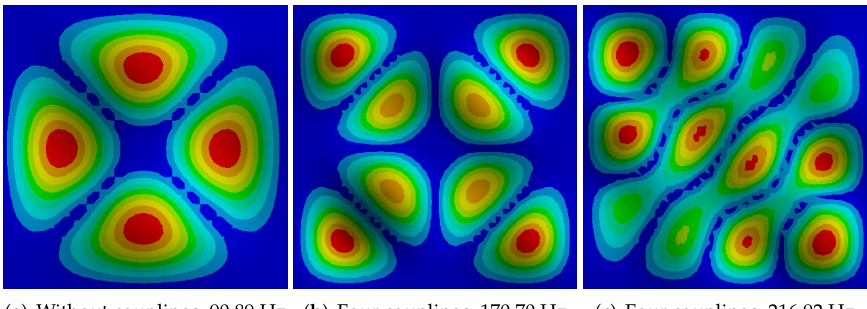
Figure 16. ANSYS models with different mode shapes, corresponding to the experimental results (Figure 11).